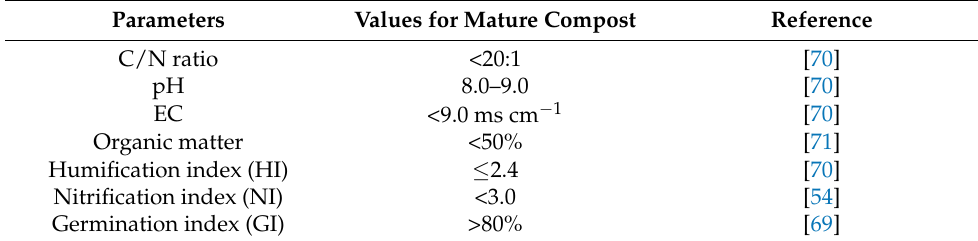
Table 3. Parameters used to assess compost